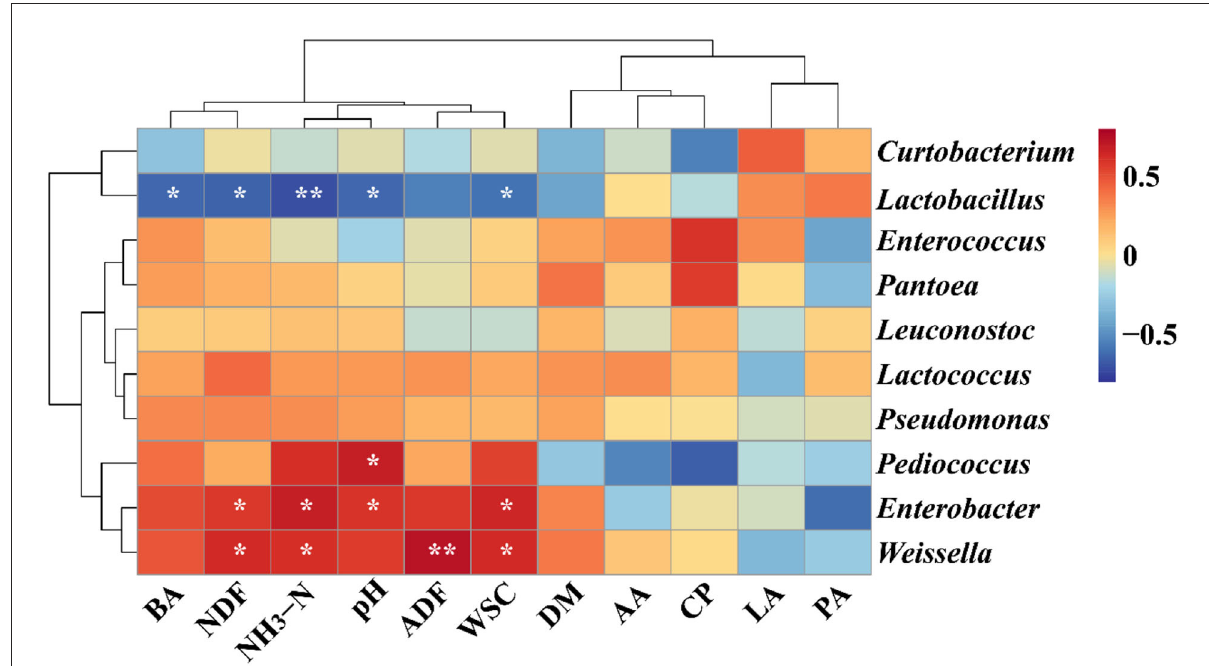
FIGURE2 Correlation analysis between genera (top 10 significant genera) and ensiling performance of native grass silage inoculated without or with lactic acid bacteria. *Significant correlation at p < 0.05 level, **Significant correlation at p < 0.01 level. DM, dry matter; WSC, water-soluble carbohydrates; CP, crude protein; ADF, acid detergent fiber; NDF, neutral detergent fiber; NH 3 -N, ammonia nitrogen; LA, lactic acid; AA, acetic acid; PA, propionic acid; BA, butyric